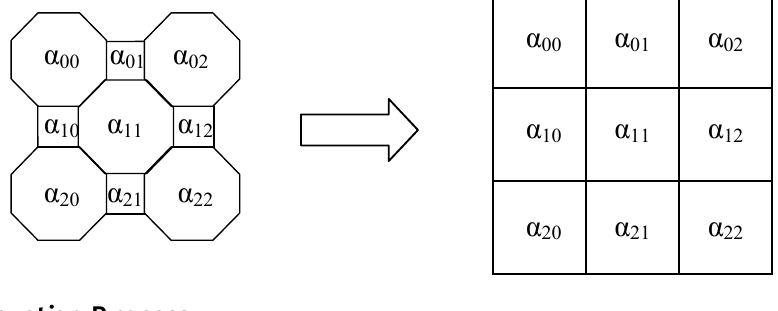
Figure 6. Transformation of octagonal-square cells into square image pixels.